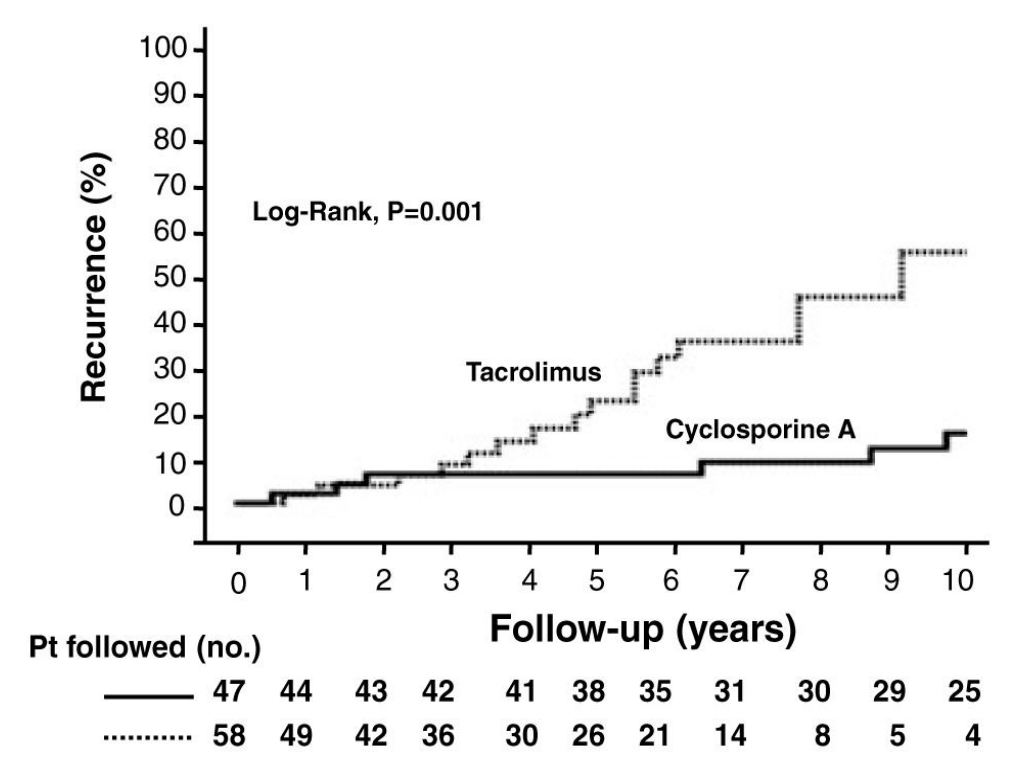
Figure 1. Cumulative probability of primary biliary cirrhosis recurrence after liver transplantation according to use of cyclosporine A (—) and tacrolimus (- – -). The 5-year probability of recurrence was 7% and 21%, respectively (p = 0.001, log-rank test). The 10-year probability of recurrence was 13% and 58% in these same groups, but fewer patients were followed. (With permission of John Wiley and American Journal of